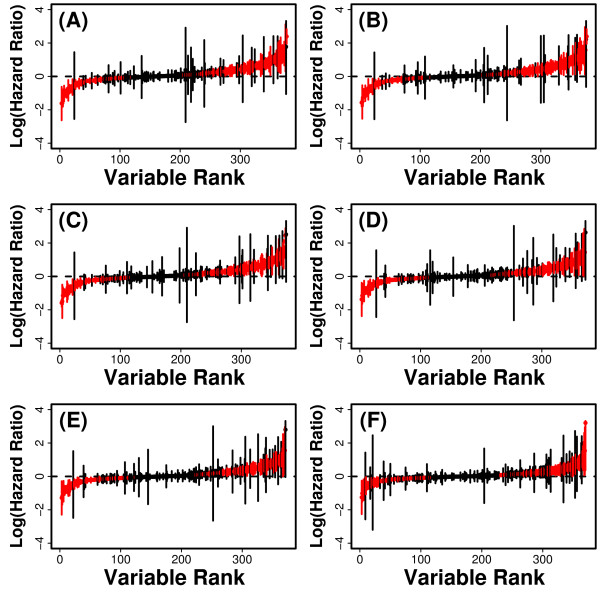
Hazard ratios. Cox PH models were used to calculate the hazard ratio associated with each of the 377 predictor variables. In each plot, vertical lines represent 95% confidence intervals associated with log-transformed hazard ratios, with red lines indicating statistical significance of estimated ratios (P < 0.05). Lines representing confidence intervals are ordered with respect to a variable ranking based upon the hazard ratio point estimate obtained for each variable. In part (A), hazard ratios for each predictor variable were estimated using a univariate model without other covariate terms. In parts (B) - (F), hazard ratios were adjusted for one or more covariates. These covariates include (B) baseline age, (C) age and smoking history, (D) age, smoking and diabetes history, (E) age, smoking history, diabetes history and hypertension, and (F) age, smoking history, diabetes history, hypertension and self-rated health.